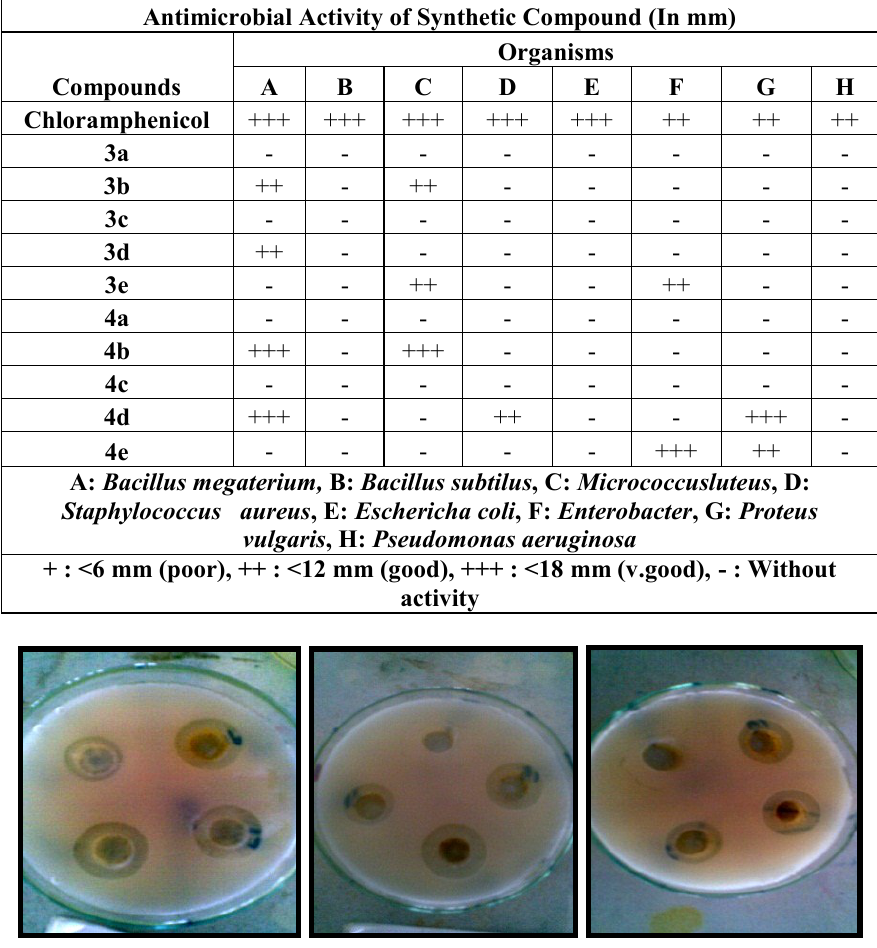
Figure 3: antibacterial activity of Pyrazoline